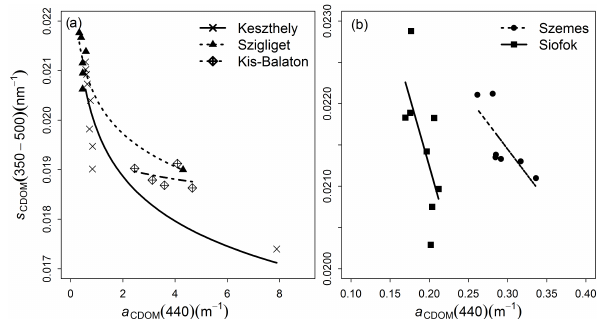
Figure 7. Plot of S CDOM (350–500) as a function of a CDOM (440) spatial variation. (a) Kis Balaton, S CDOM (350–500) = 0 . 019266 · a CDOM (440) − 0 . 017362 ; basin Keszthely, S CDOM (350–500) = 0 . 019817 · a CDOM (440) − 0 . 070820 and basin Szigliget, S CDOM (350– 500) = 0 . 020418 · a CDOM (440) − 0 . 070820 . (b) Basins Szemes, S CDOM (350–500) = − 0 . 01252 · a CDOM (440) + 0.02521 and Sio- fok, S CDOM (350–500) = − 0 . 03330 · a CDOM (440) +